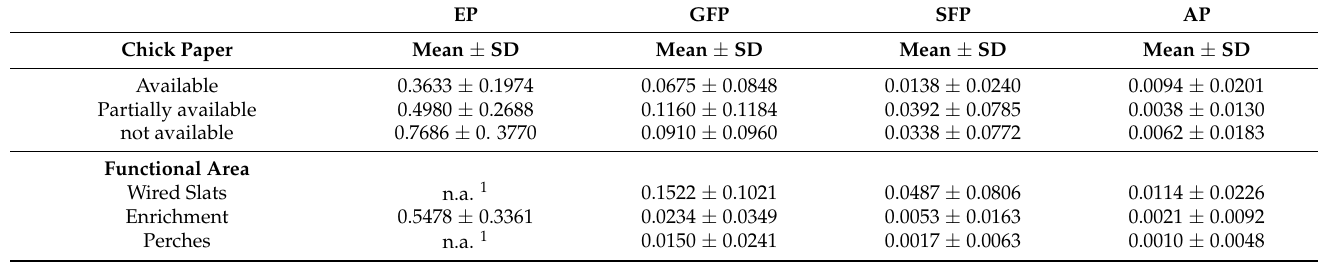
Table 3. Descriptive analysis of the average number of pecks (Mean ± SD) depending on the availability of chick paper and in the different functional areas during all observations (days of life 1, 8, 15, 22, and 29) and experimental groups in both rearing periods: Enrichment pecking (EP); gentle feather pecking (GFP); severe feather pecking (SFP); and aggressive pecking (AP). Chick paper was available for all chicks on days of life 1 and 8, and not or partially available on days of life 15, 22 and 29. Behavior was observed in eight compartments per experimental group (not enriched, high stocking rate; enriched, low stocking rate and enriched, high stocking rate) in both rearing periods with two cameras per compartment. On days of life 1 and 8 we analyzed 15 min and on the remaining days (15, 22 and 29) 9 min per day and camera. EP GFP